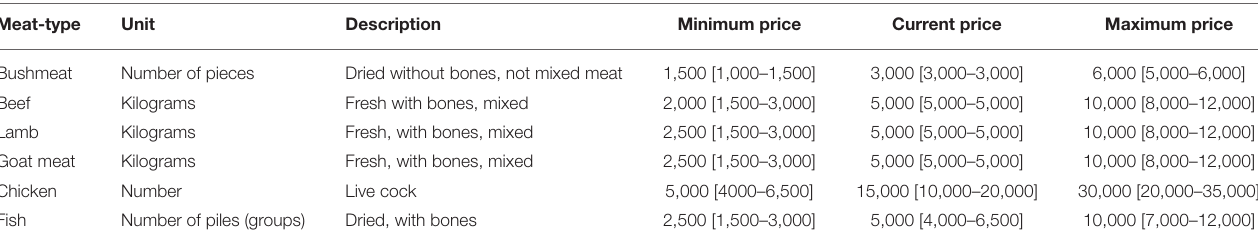
TABLE 2 | List of substitute meat types and characteristics i.e. measurement unit, description, minimum, current, and maximum prices in TSH.